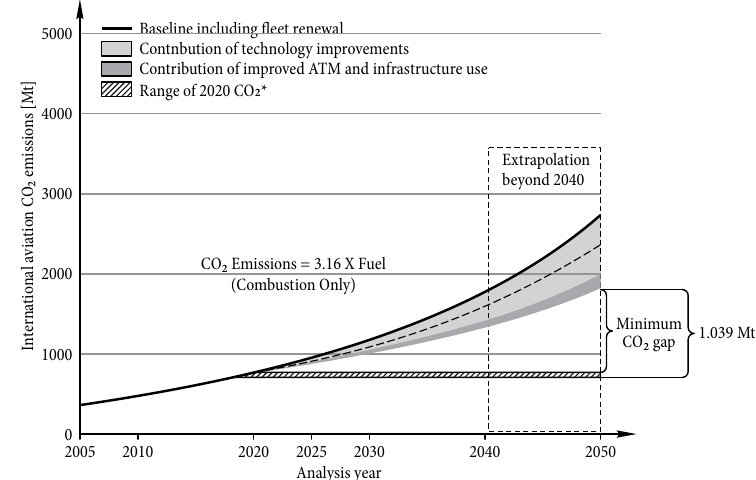
Baseline ncluding leet enewali